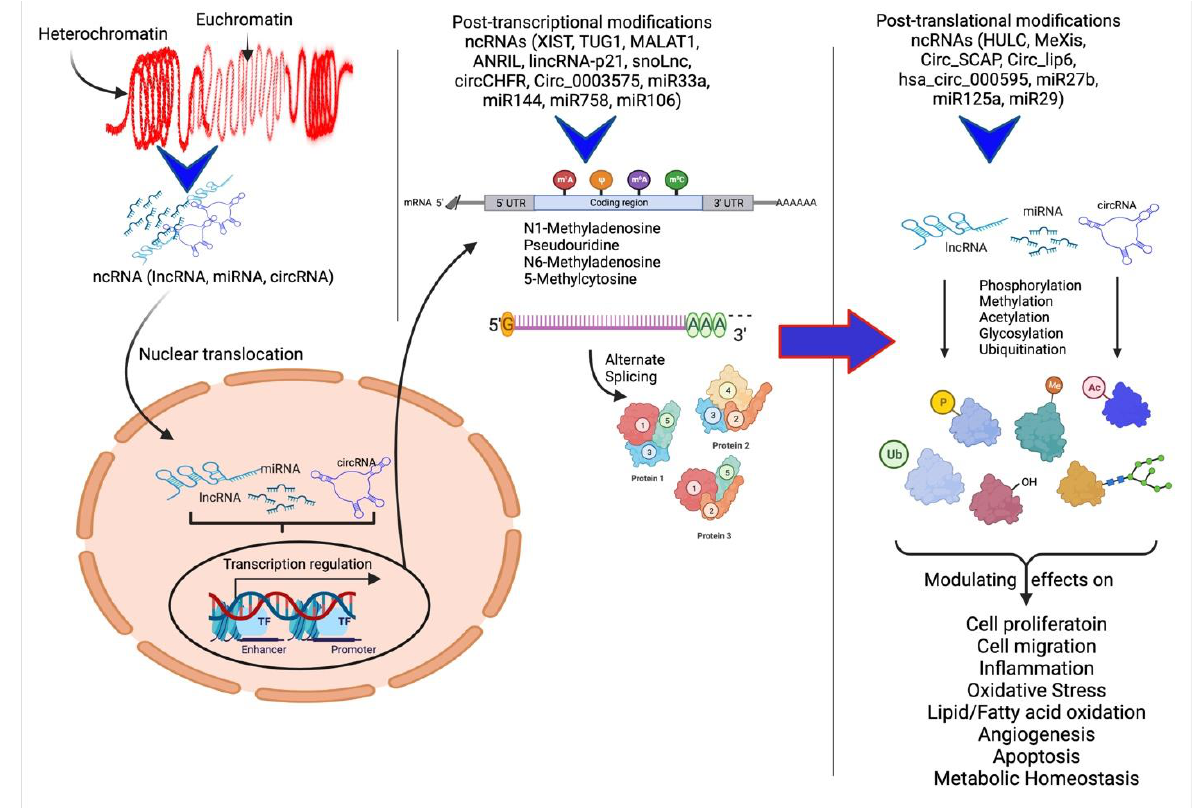
Figure 2. Schematic representation of ncRNAs acting on various cellular processes and their modulatory effects. Non-coding RNAs (ncRNAs) regulate gene expression at the transcriptional and post-transcriptional levels and are also involved in the epigenetic regulation of various genes. The ncRNAs play a critical role in heterochromatin formation and histone modification involving methylation, acetylation, ubiquitination, citrullination, alternative splicing, and gene silencing. Modified protein structure and levels regulate various molecular mechanisms involved in angiogenesis, cell proliferation and migration, inflammation, and remodeling.